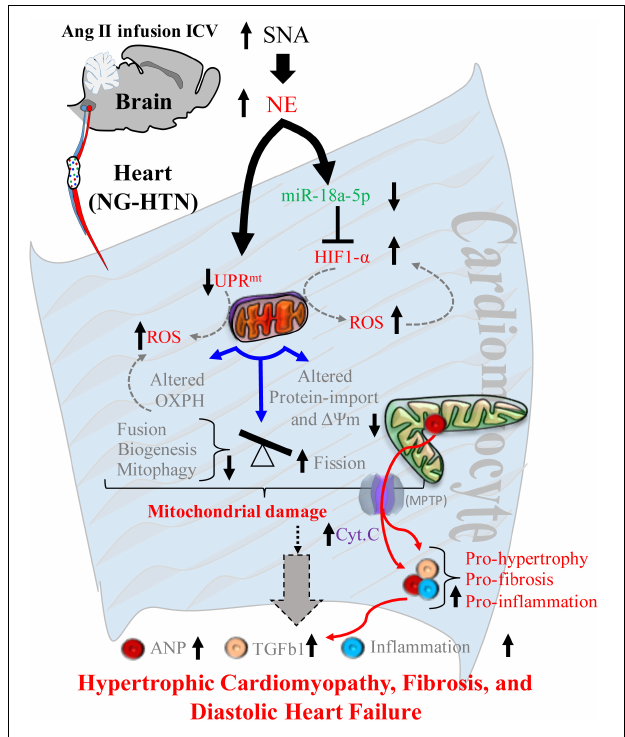
FIGURE 12 | Schematic showing mechanisms of mitochondrial dysfunction in central Ang II (ICV) infusion induced NG-HTN. Schematic model showing proposed molecular mechanisms causing mitochondrial abnormality in the heart of rat with neurogenic hypertension resulting in progression to hypertrophic cardiomyopathy. An increased sympathoexcitation (SNA) induces an increase in cardio-neuronal norepinephrine which causes either UPR mt and/or miR-18a-5p/HIF-1 α axis dysregulation that leads to increased mitochondrial ROS generation. Increased ROS alters mitochondrial OXPHOS, protein-import, and mitochondrial dynamics to tip the balance of Fusion/Fission to greater Fission, leading to overall mitochondrial abnormality. These underlies ROS induced release of mitochondrial cytochrome-c into cytoplasm via mitochondrial permeability transition pores (MPTP) opening eventually mitochondrial abnormality that progressively contributes to hypertrophic remodeling, fibrosis, inflammation and diastolic heart failure in the rats with